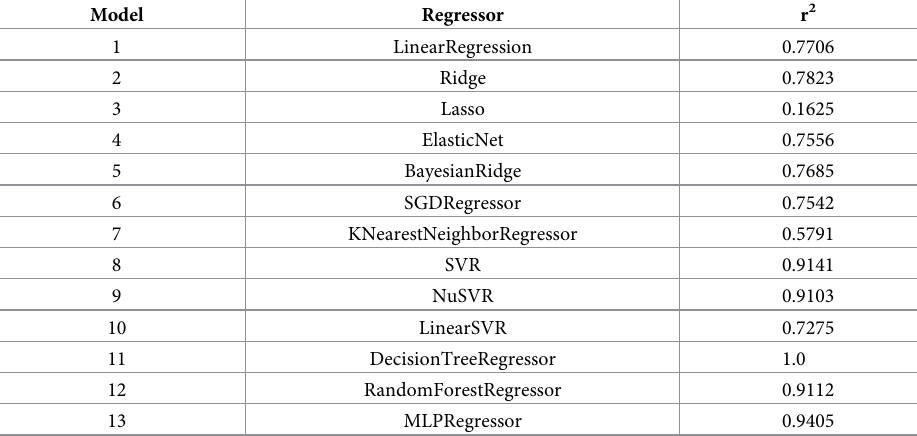
Table 1. Search for the best regressor algorithm for